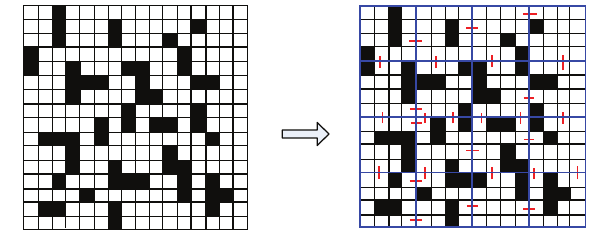
Figure 9: Grid to 16 subgrids.